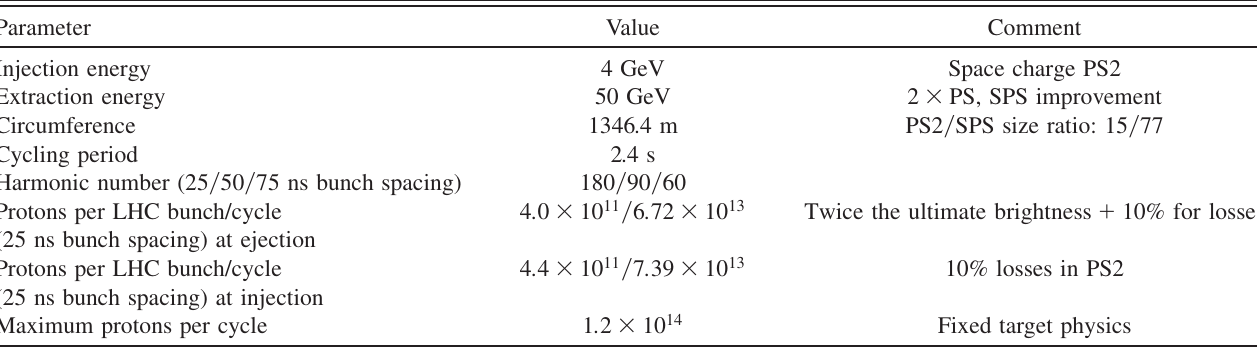
TABLE I. PS2 parameters.